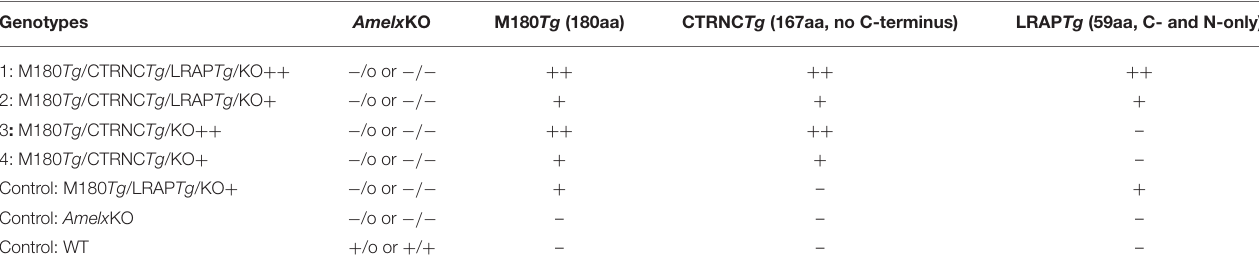
TABLE 2 | Mouse genotypes (KO and transgenic status) as determined by PCR for genotyping for endogenous amelogenin and qPCR for measuring relative copy number of the three transgenes, using transgene-specific probes against M180 Tg , CTRNC Tg , and LRAP Tg .